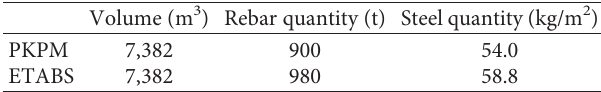
Table 8: Concrete and rebar quantity comparison designed by PKPM and